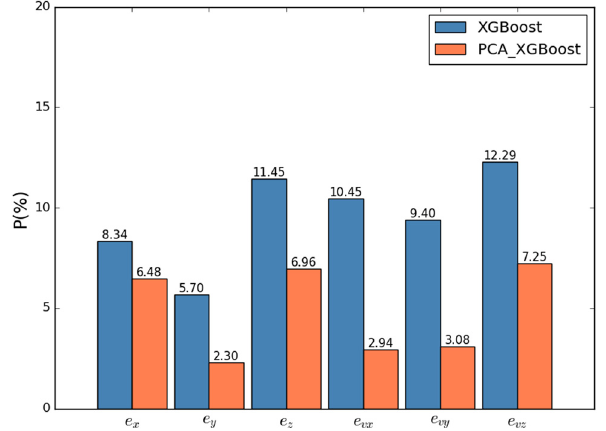
Figure 3: Comparison of XGBoost and the proposed PCA – XGBoost model for six components in training dataset ( training in week → 1 3 )